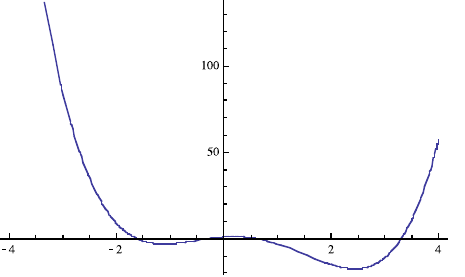
Figure 3. The plot of a quartic polynomial. For the sake of illustration we set 𝜇 (cid:2872),(cid:2868) = 1 ; 𝜇 (cid:2871),(cid:2869) = −4 ; µ = 6; µ = 2 and µ = 2,2 1,3 0,4